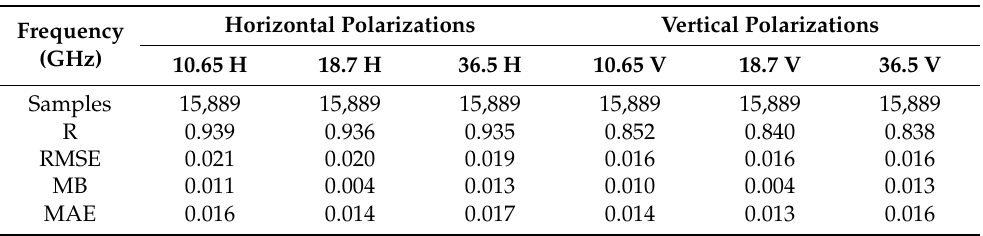
Table 5. Statistical metrics of comparison of MLSE between MLSE_Res2 and Moncet_MLSE in China during summer 2003.